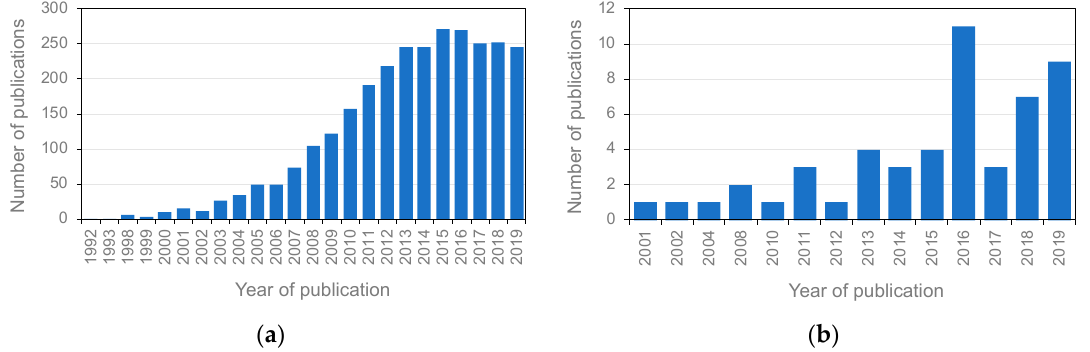
Figure 1. Web of Science (Clarivate Analytics) citations published until 2019 with the topics: ( a ) chitosan and gene therapy; ( b ) chitosan, fish and gene therapy.